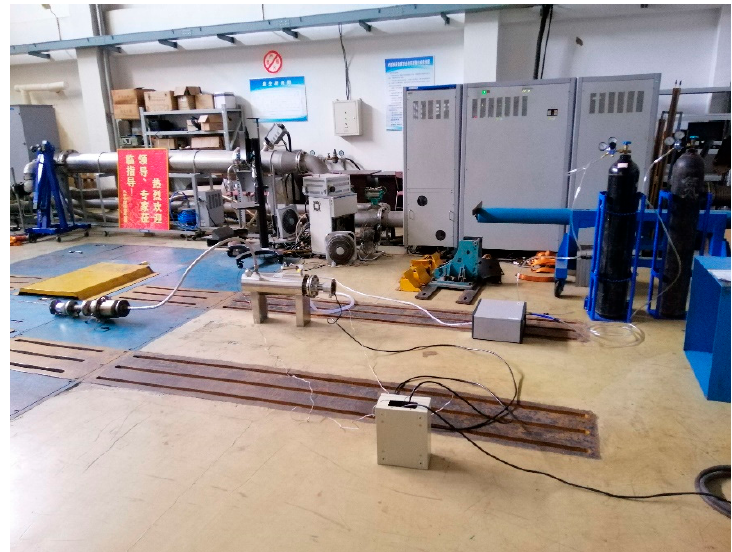
Figure 10. Experimental layout of Simulation test bench.